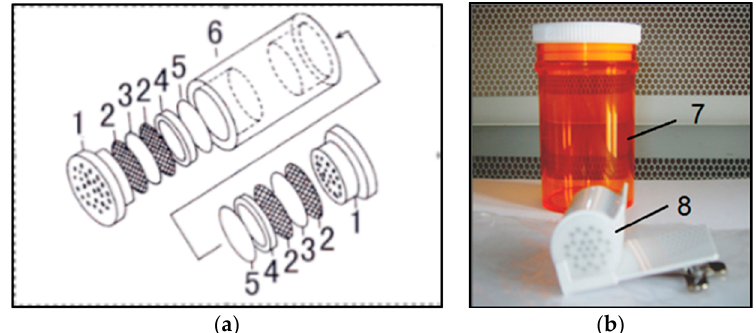
Figure 1. Ogawa passive sampler components: 1—Inlet; 2—Stainless Steel Screens; 3—Collection Pad; 4—Ring; 5—Backing Tab; 6—Body; ( a ) [22]. 7—Plastic Sample Container; 8—Assembled Sampler ( b ).